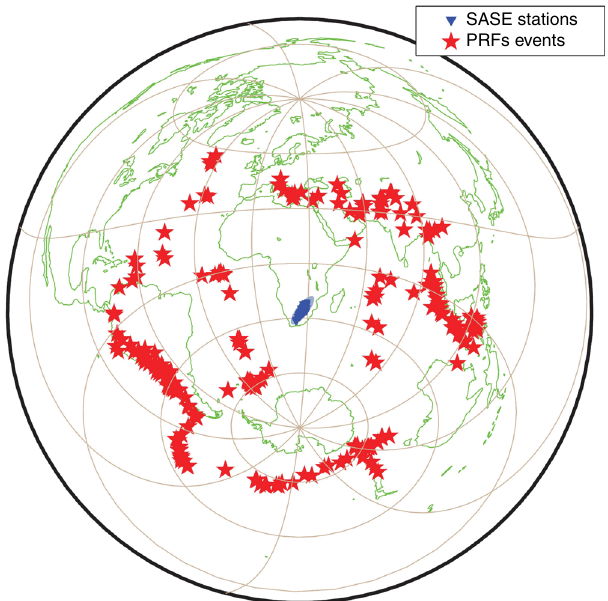
Fig. 2 Event distribution for the calculation of receiver functions. Red stars: seismic events, blue area: region covered with seismic stations during the SASE experiment. The events cover all back-azimuth directions with a broad distribution of epicentral